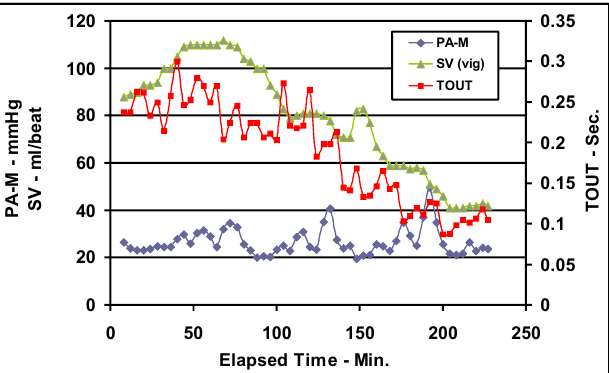
Figure 10. Mean pulmonary arterial pressure (PA-M), stroke volume (SV), and time of venous outflow (TOUT) vs. elapsed